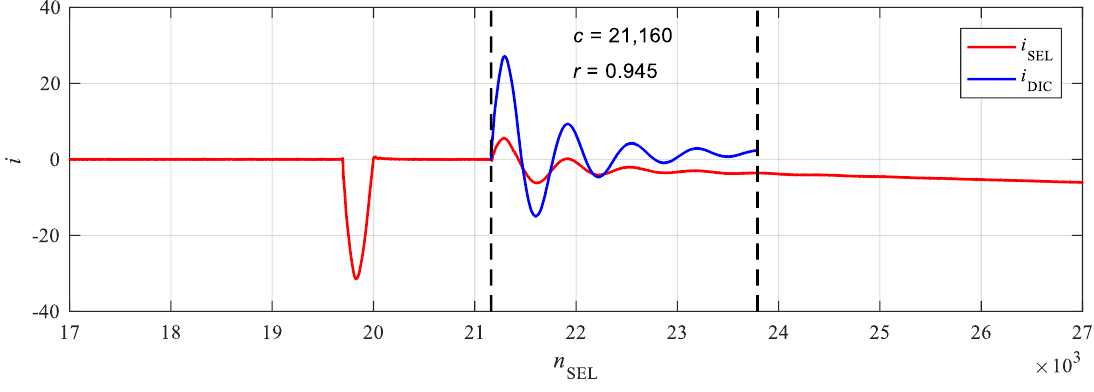
Figure 10. Determining the correlation for sample measurement data, delay c = 21,160.